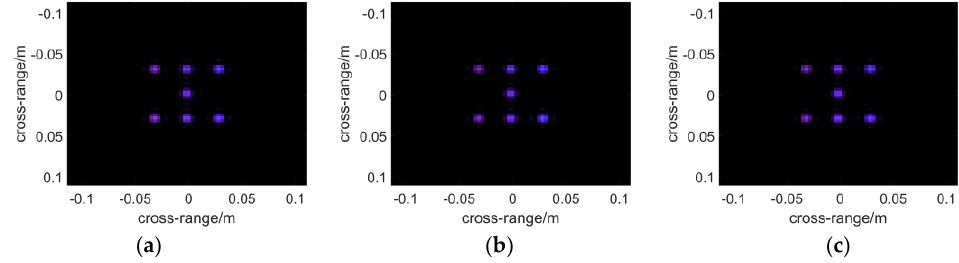
Figure 7. The 3-D reflectivity coefficients calculated with the algorithm of: ( a ) BPA; ( b ) RMA; ( c ) PMA. The brightness of each pixel represents the maximum modulus of the complex voxels along the range direction, while the color, which ranges from red to blue with increasing distance, of each pixel indicates the position where the maximum modulus is situated.